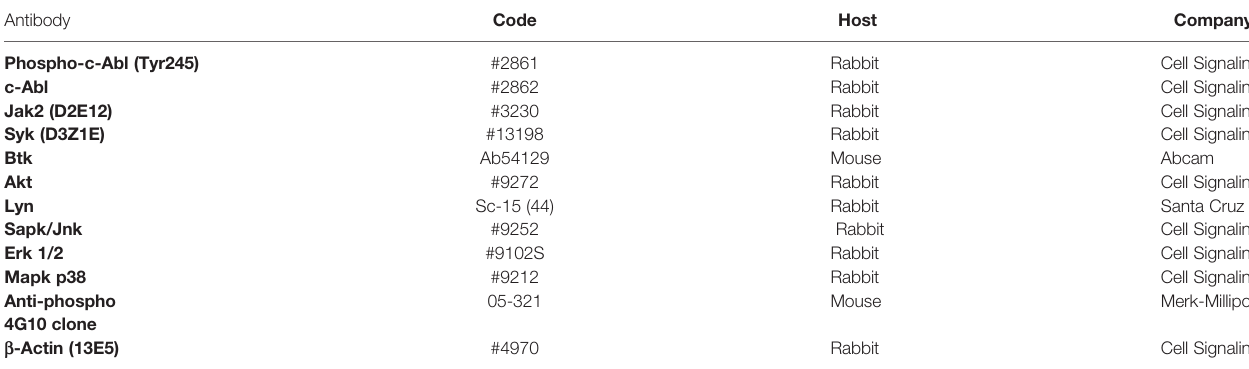
TABLE 3 | List of antibodies.